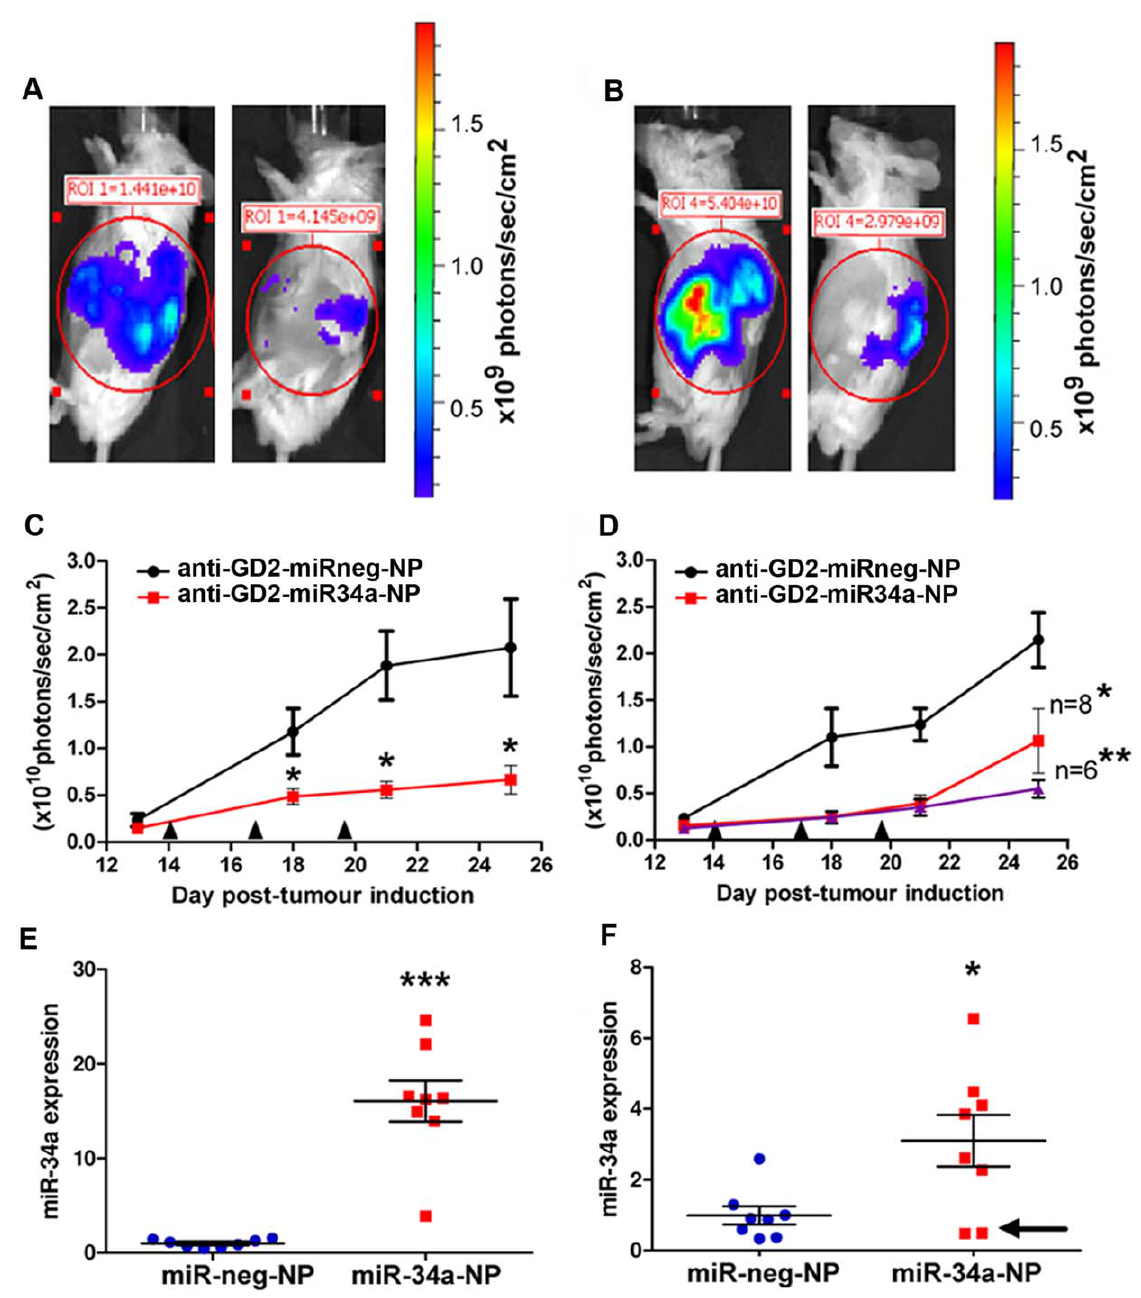
Figure 3. Anti-neuroblastoma effect of anti-GD 2 conjugated nanoparticles bearing miR-34a in vivo. Bioluminescent images representative of mice bearing (A) NB1691 luc tumors treated with anti-GD 2 -miRneg-NP (left) or anti-GD 2 -miR34a-NP (right), along with representative mice bearing (B) SK-N-AS luc tumors treated with anti-GD 2 -miRneg-NP (left) or anti-GD 2 -miR34a-NP (right) were obtained at day 25. Tumor growth curves from (C) mice bearing NB1691 luc tumors treated with anti-GD 2 -miRneg-NP (black line) or anti-GD 2 -miR34a-NP (red line) and (D) mice bearing SK-N-AS luc tumors treated with anti-GD 2 -miRneg-NP (black line) or anti-GD 2 -miR34a-NP (red line). Time points for systemic administration of nanoparticles are indicated by the symbol m . Differences in tumor growth between mice injected with anti-GD 2 -miR34a-NP versus anti-GD 2 -miRneg- NP were statistically significant for both models (NB1691 luc n=8, *p , 0.05) (SK-N-AS luc *p , 0.05 for n=8 and **p , 0.01 for n=6). For the SK-N-AS luc model, two tumors grew significantly faster than the median and are represented in the growth curve for all 8 tumors (red line). The purple line represents the growth curve without these two tumors (n=6). Mature miR-34a transcript levels were significantly higher in anti-GD 2 -miR34a-NP treated tumours relative to anti-GD 2 -miRneg-NP-treated control tumors in both the (E) NB1691 luc (***p , 0.001, n=8) and (F) SK-N-AS luc (*p , 0.05, n=8). Notably, the two SK-N-AS tumors with increased growth from (D) had poor uptake of miR-34a (arrow).